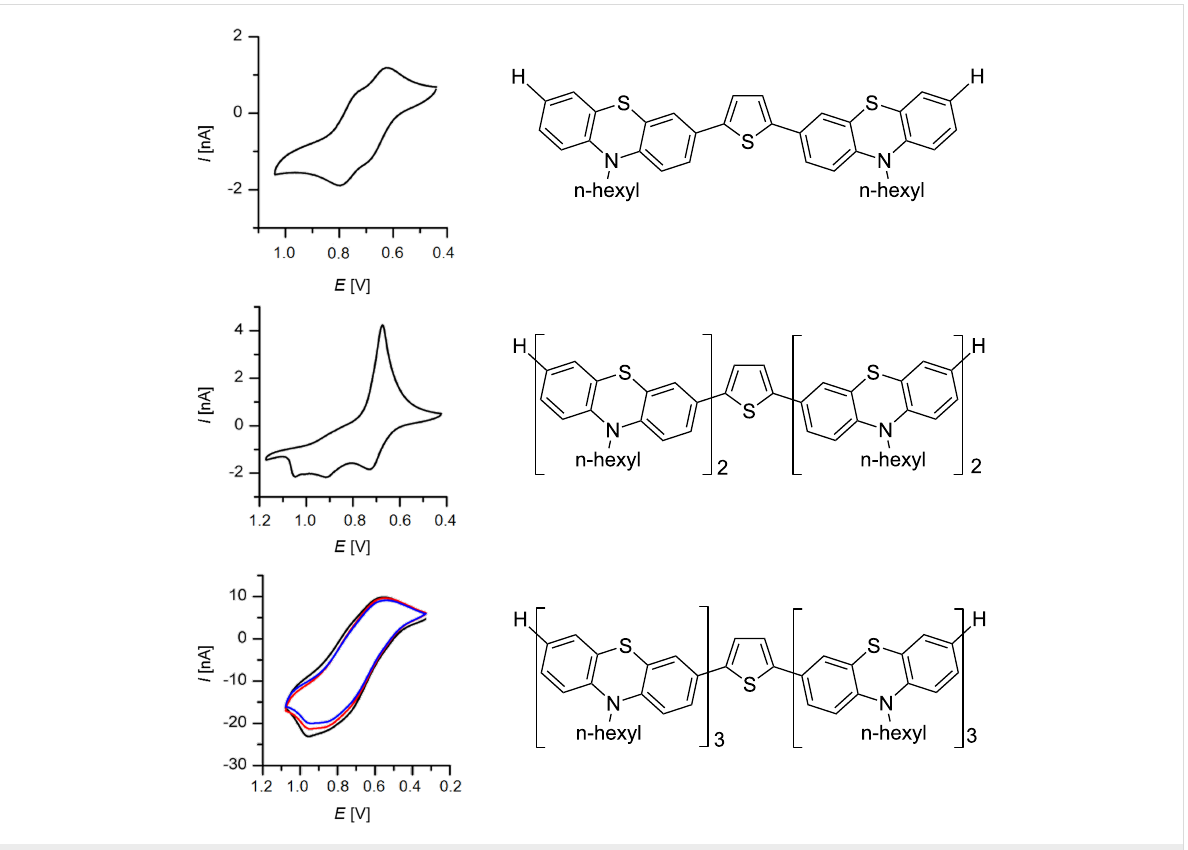
Figure 2: Cyclic voltammograms of compounds 3 (recorded in CH 2 Cl 2 , T = 293 K, electrolyte n- Bu 4 N + PF 6 − , Pt working electrode, Pt counter elec- trode, Ag/AgCl reference electrode, v = 50 mV/s ( 3a and 3b ), v = 100 mV/s ( 3c , multisweep experiment, 1. cycle (black), 2. cycle (red), 3. cycle